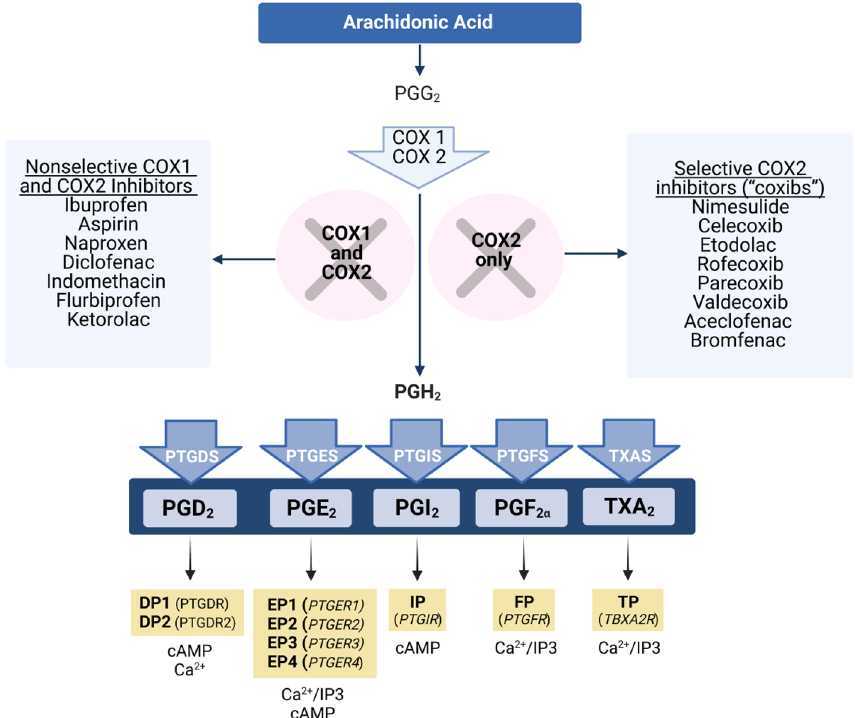
Figure 1. Prostaglandins biosynthesis pathway. Cyclooxygenases (COX) metabolize arachidonic acid first to prostaglandin